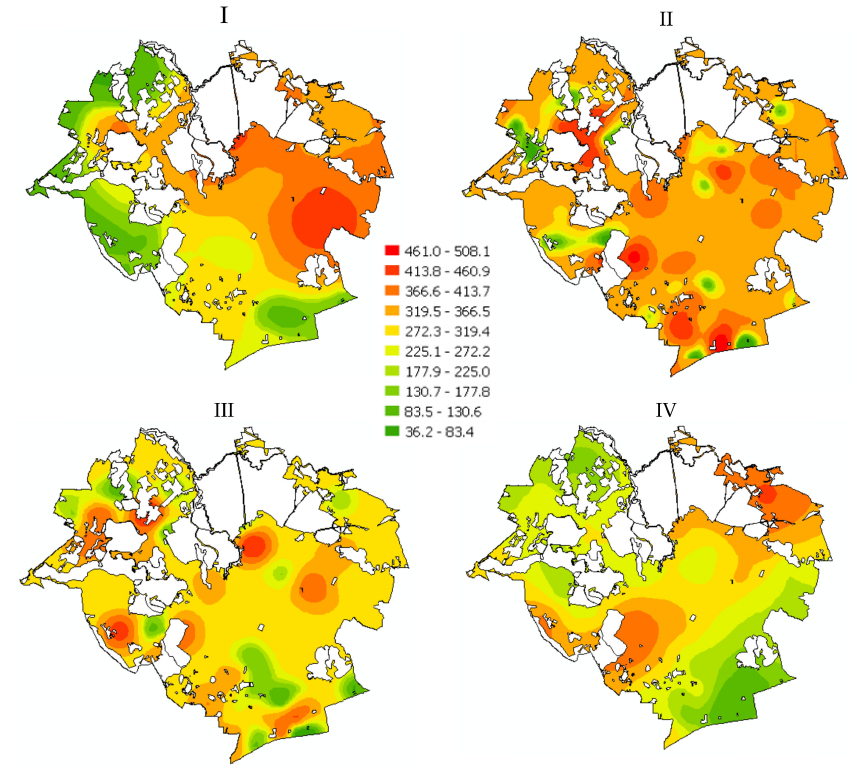
Figure 8. Spatial interpolation of simulated transaction